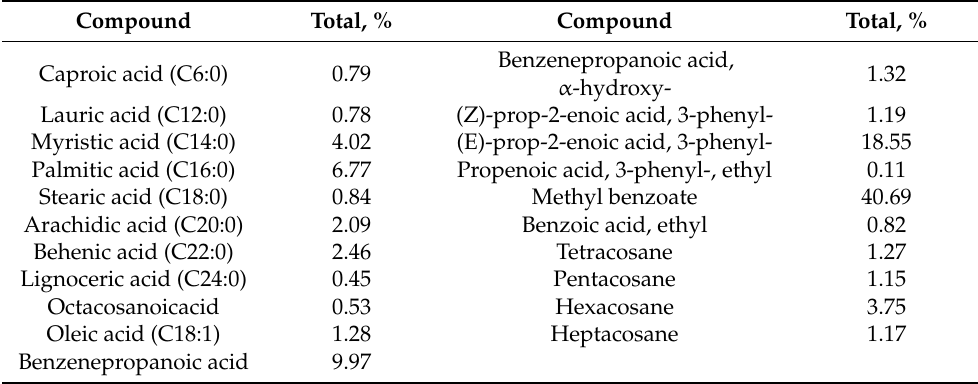
Table 2. Identification of lipid compounds in O. pseudoglandulosa